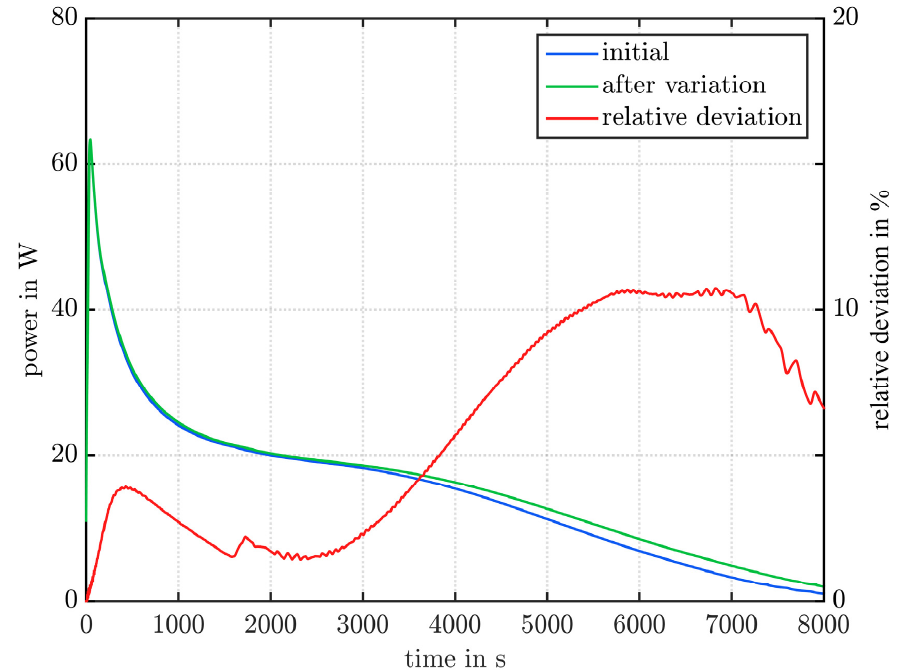
Figure 9. Power over time curve for charging of the standard case and the case with an increased melting enthalpy as well as the regarding relative deviation.